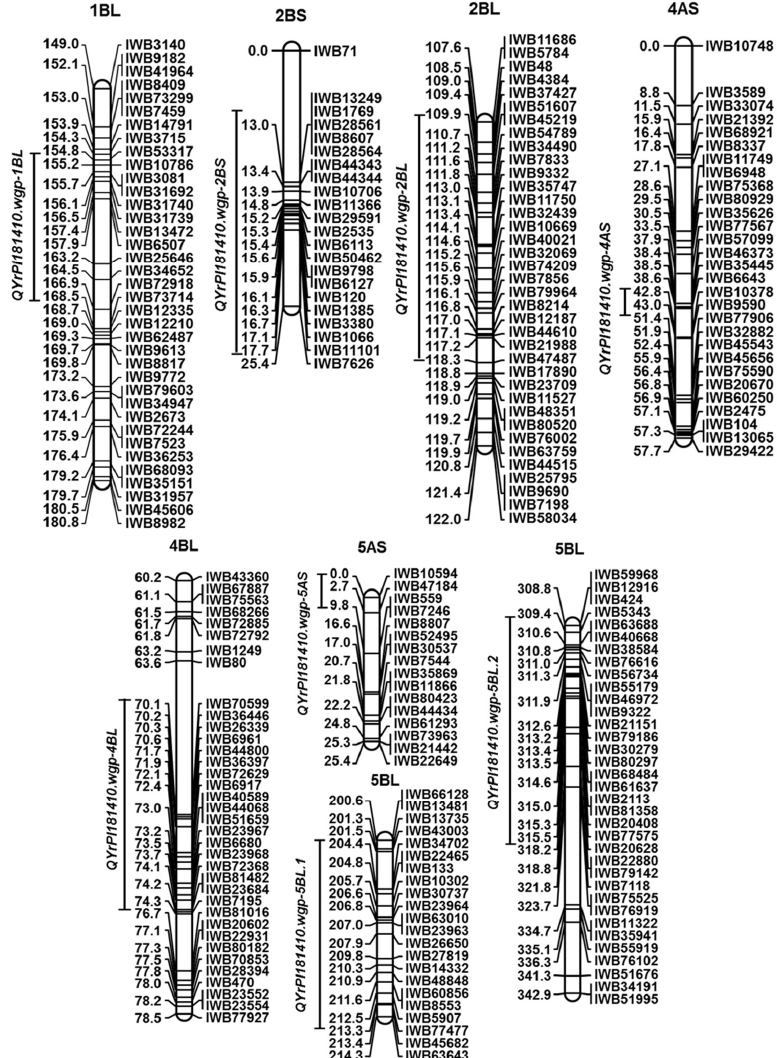
Figure 3. Genetic maps for the eight stripe rust resistance QTL identified in PI 181410 and AvS in this study. The solid bars on the left of each genetic map indicate the QTL position and interval. QYrPI181410.wgp-4AS was detected by SNP IWB9590 with the logarithm of odds (LOD) of 3.3 and 2.7 for PSTv-4 and PSTv-14, respectively (Table 4). It peaked at the genetic location of 43.0 cM